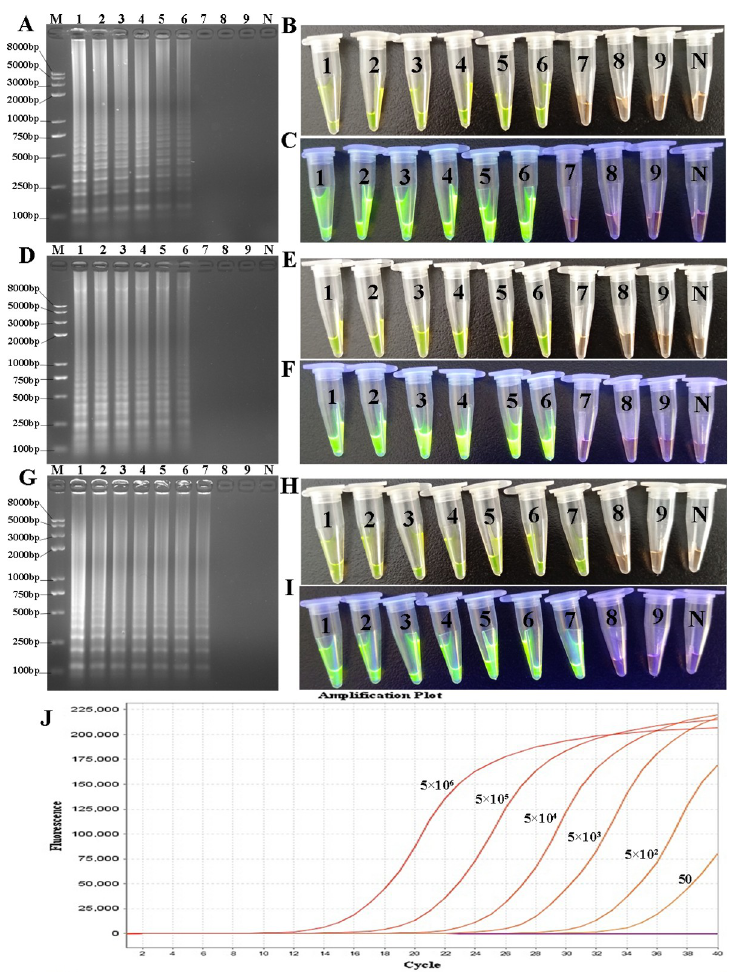
Fig 7. Sensitivities of LAMP, CPA, IMSA and real-time PCR. A, D and G, Agarose gel electrophoresis analysis of LAMP, CPA and IMSA reactions; B, E and H, Direct visualization under natural light after staining with SYBR Green I for LAMP, CPA and IMSA reactions; C, F and I, Visualization under UV light after staining with SYBR Green I for LAMP, CPA and IMSA reactions; J, real-time PCR reaction; 1–9, 5 × 10 6 , 5 × 10 5 , 5 × 10 4 , 5 × 10 3 , 5 × 10 2 , 5 × 10 1 , 25, 15 and 5 CFU/mL, respectively; M, Trans 2K plus II DNA marker; N, negative control.